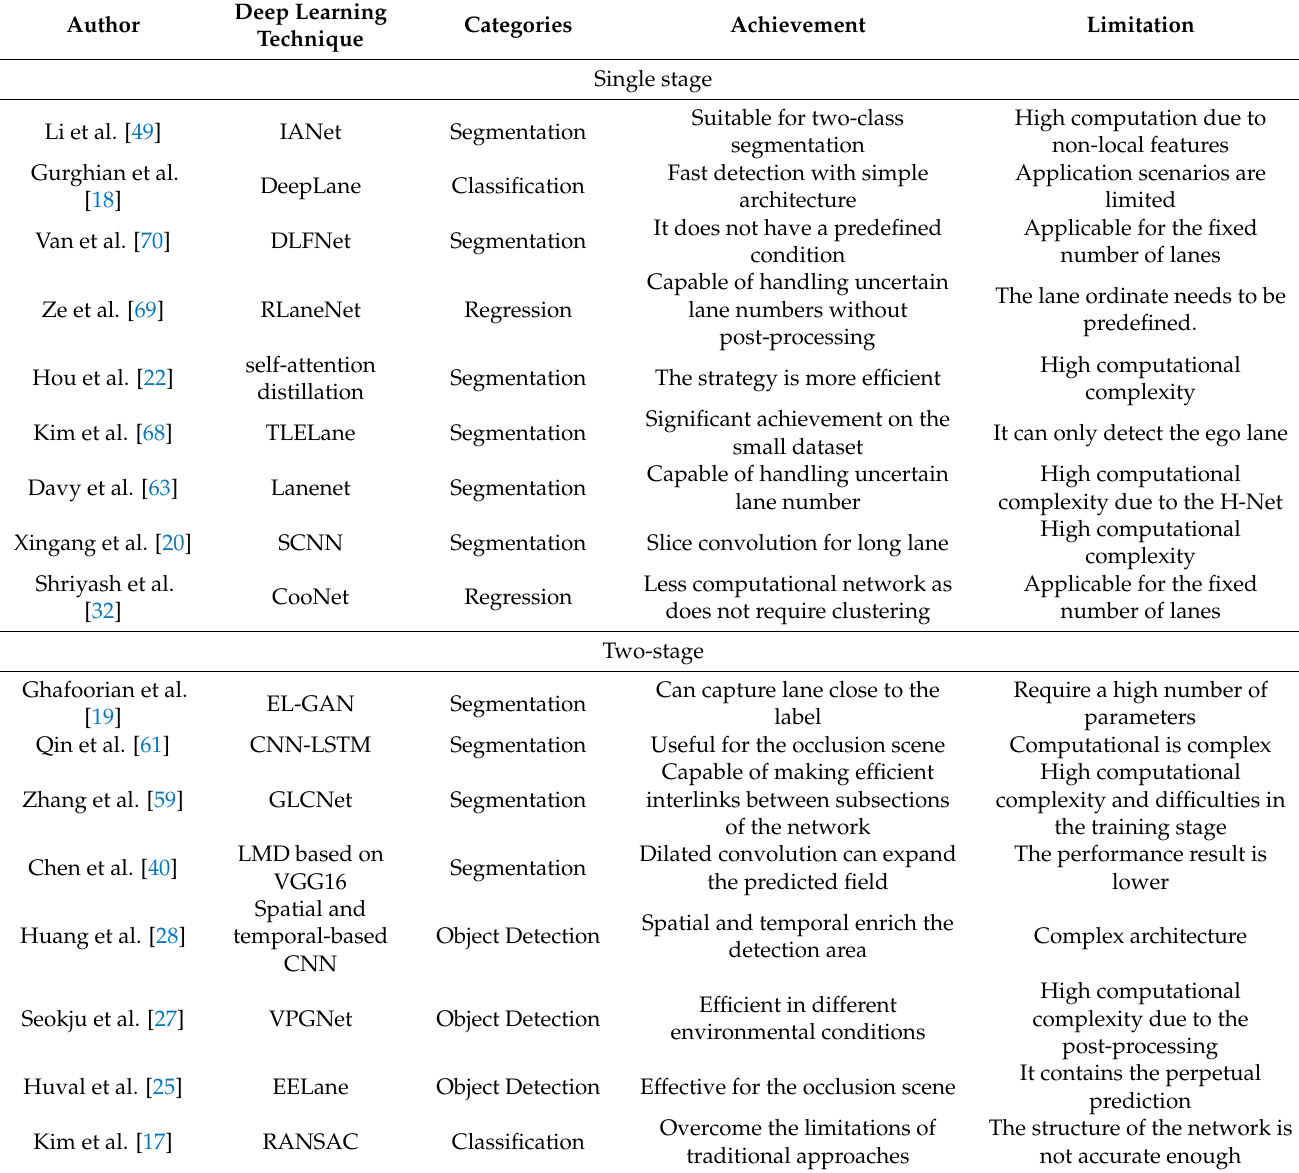
Table 1. Summary of lane detection techniques using DNN.